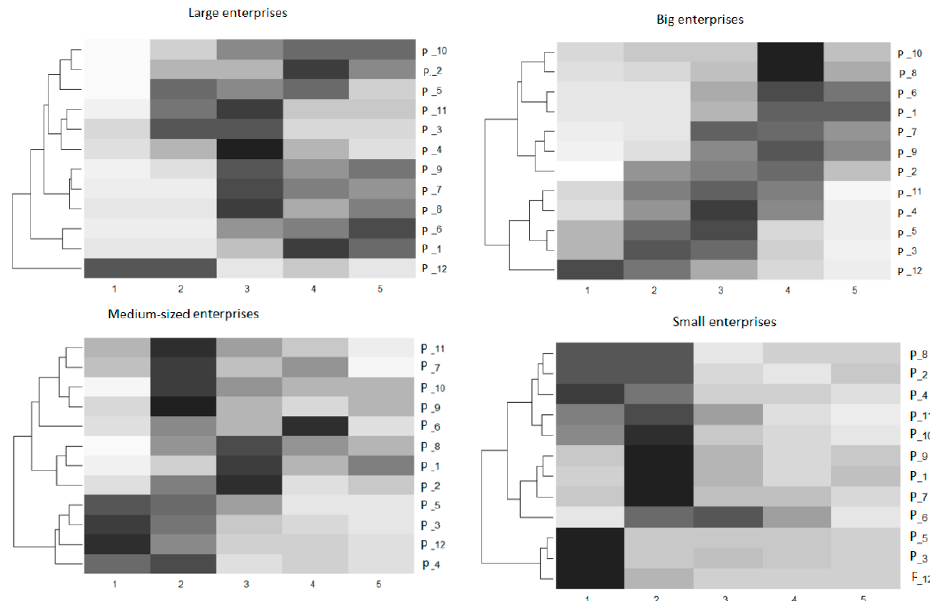
Figure 4. Degrees of SM project implementation in the steel enterprises in Poland. Source: own research for N = 79 [123].